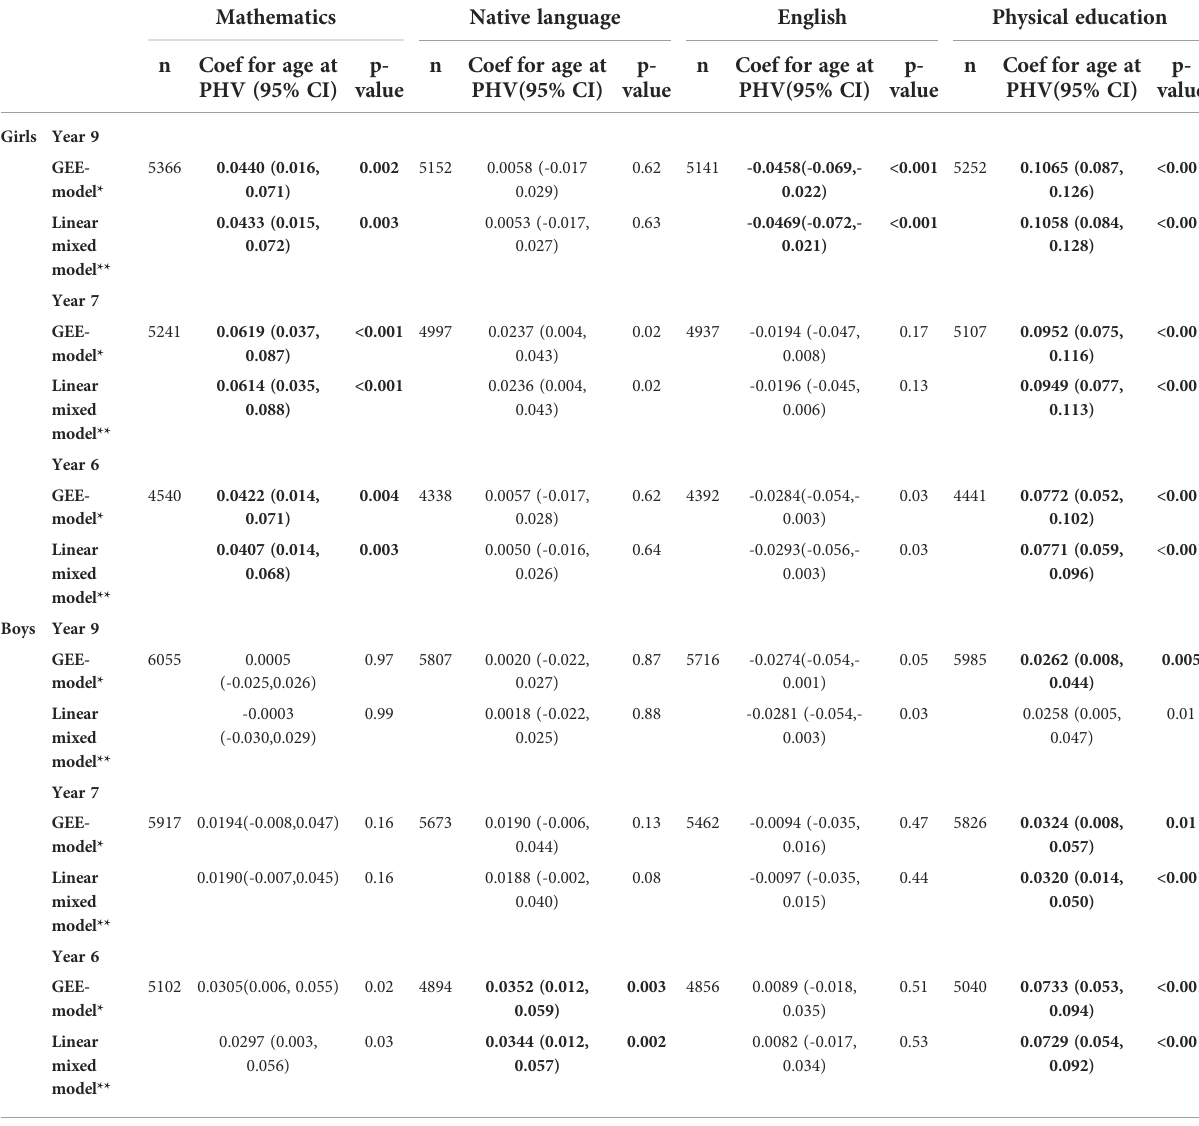
TABLE 1 Results from GEE and linear mixed models for boys and